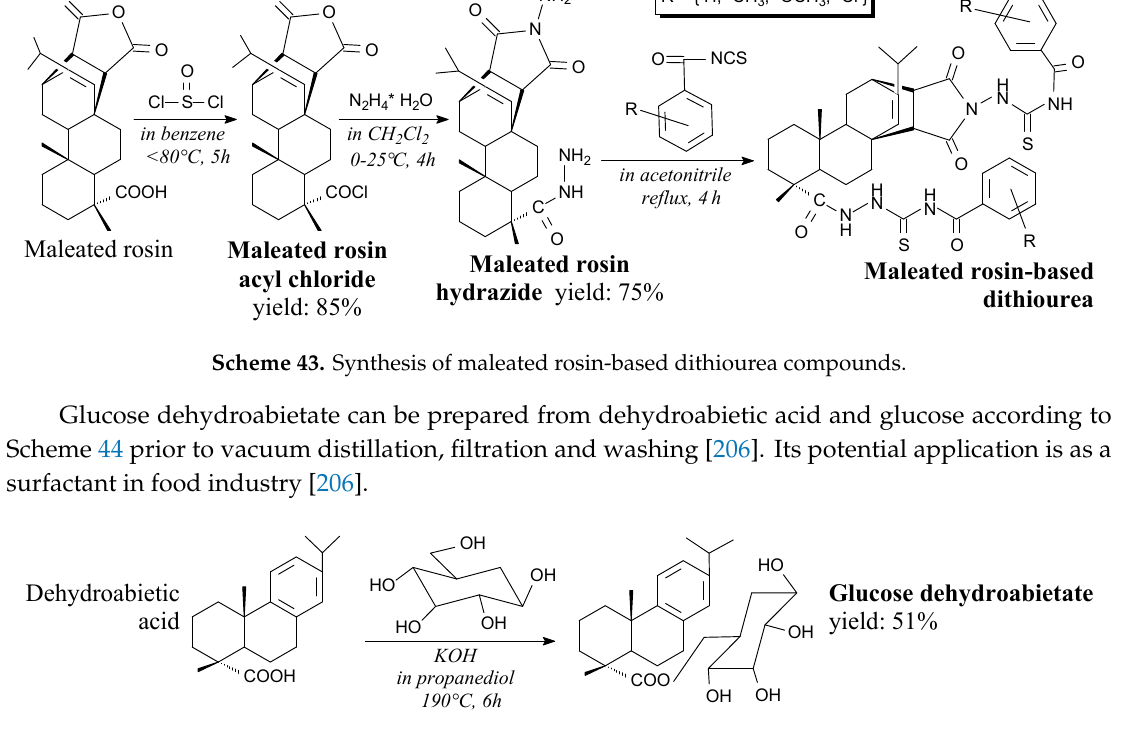
Scheme 44. Preparation of glucose dehydroabietate.